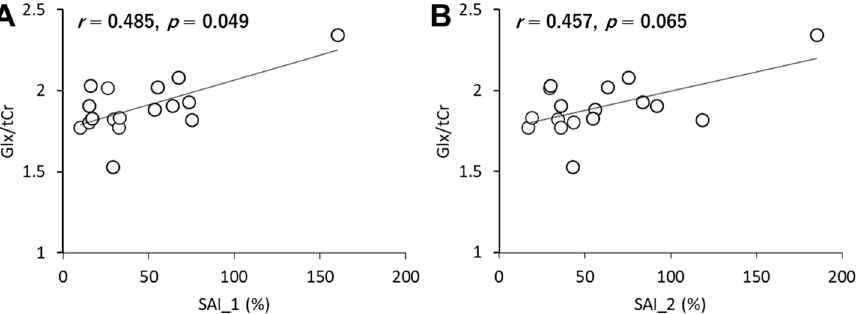
Figure 5. Association between SAI and Glx in the M1. ( A ) SAI_1 and Glx. ( B ) SAI_2 and